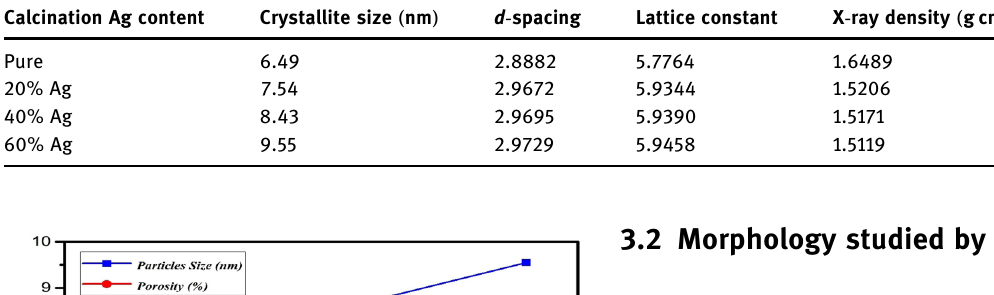
Table 2: Lattice parameters for pure PbS and Ag:PbS at ( a ) 20%, ( b ) 40%, and ( c ) 60% Calcination Ag content